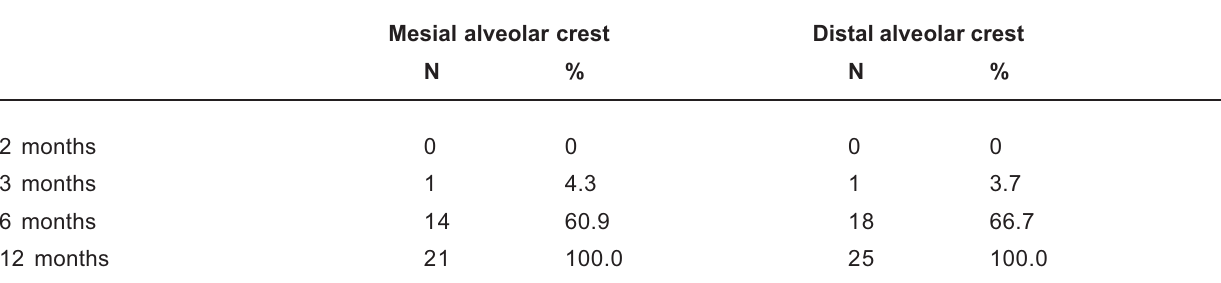
TABLE 1- Number of alveolar crests and presence of intact lamina dura